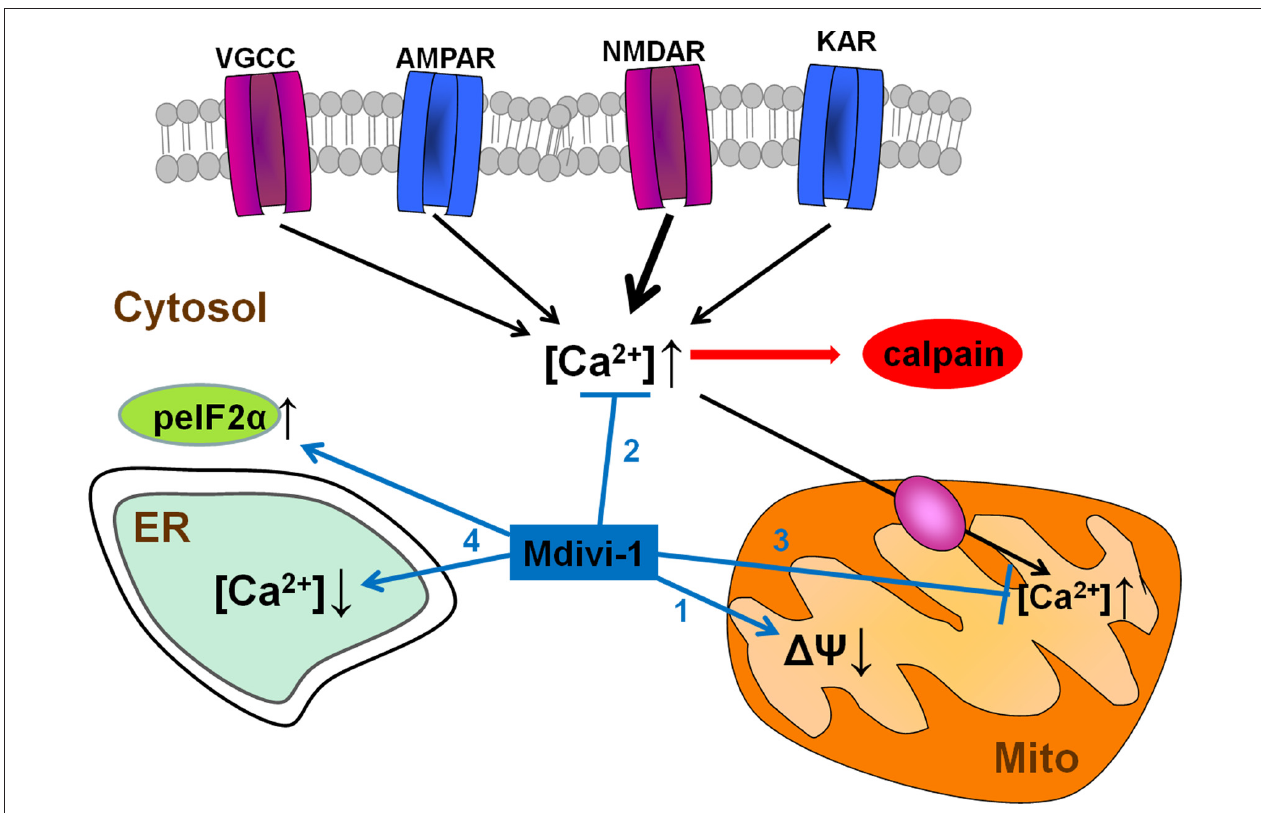
FIGURE 9 | Neuroprotective pathways of mdivi-1. Mdivi-1 induces a moderate inhibition of mitochondrial respiration, and a drop in mitochondrial membrane potential (1). It also attenuates cytosolic Ca 2 + overload due to activation of VGCCs and glutamate ionotropic receptors, and consequently, downstream NMDAR-dependent calpain activation (2). Mdivi-1-induced mitochondrial depolarization reduces mitochondrial Ca 2 + uptake and therefore prevents excitotoxic [Ca 2 + ] mit overload (3). Mdivi-1 partially depletes ER Ca 2 + store and enhances peIF2 α phosphorylation (ISR; 4), events that provide cytoprotection against a variety of stress